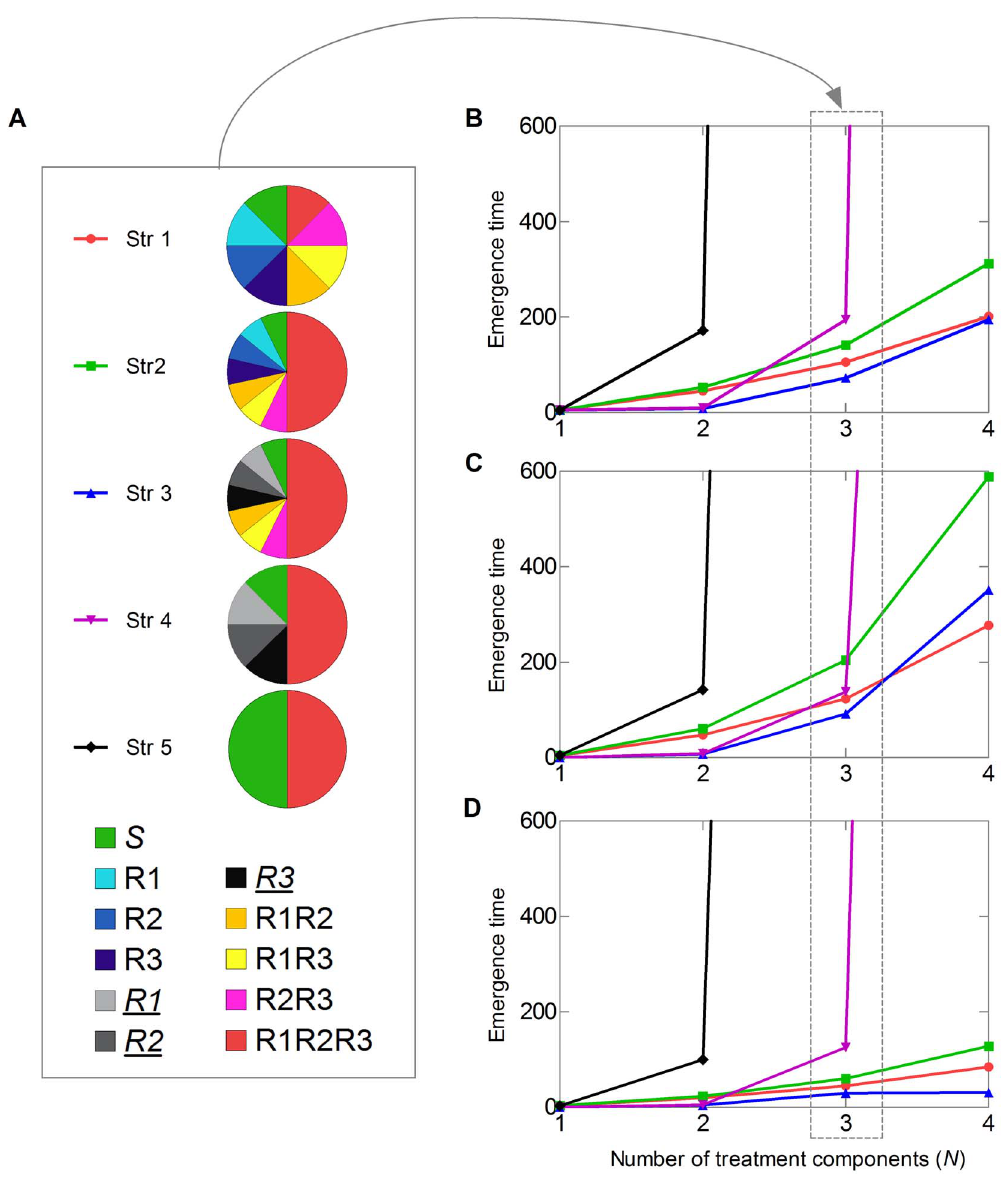
Figure 2. Emergence time as a function of the number of treatment components ( N ) for five different management strategies, Str1, ... , Str5. Pie charts (A) depict the composition of a diversified host population by the deployment of a three-component treatment ( N ~ 3 ): each color corresponds to a host type listed below, and the proportion of each host type corresponds to a pie sector. Host type S includes untreated hosts, types R1, R2, R3 and R1 , R2 , R3 - hosts receiving different monocomponent treatments, host types R1R2, R1R3, R2R3 receiving different intermediate treatments, and type R1R2R3 consists of hosts receiving a three-component treatment. Host types with italic and underline names receive defeated treatments that have already been overcome. For the detailed description of the management strategies, see the text in Materials and Methods section. We used the same deployment principle for the N -component treatment, N [ f 1, ... ,4 g . In (B), the pathogen has low growth and migration rates, r ~ 0 : 3 and D ~ 0 : 1 . Emergence time takes high values for Str ~ 4 and N ~ 4 , S 4,4 ~ 13764 : 3 , and for Str ~ 5 and N ~ 3 , S 5,3 ~ 12372 : 7 o . In (C), the pathogen has a low growth rate and a medium migration rate, r ~ 0 : 3 and D ~ 0 : 2 . S 4,4 ~ 4721 : 4 and S 5,3 ~ 9440 : 18 are the highest values of the emergence time. In (D), the pathogen has a medium growth rate and a low migration rate, r ~ 0 : 8 and D ~ 0 : 1 . S 4,4 ~ 9863 : 58 and S 5,3 ~ 8451 : 13 are the highest values of the emergence time. In (A-C), the other parameters are n ~ 10 { 3 , K ~ 10000 and C ~ 0 : 1 . In Str1, Str2 and Str5, the initial population size of the resident pathogen type is X 11 (0) ~ (1 { j ) K and for all other types ( i , j ) = (1,1) , X ij (0) ~ 0 . In Str3 and Str4, X 11 (0) ~ (1 { j ) K , X kk (0) ~ j i K where k corresponds to a host type treated with a monocomponent treatment, and for all other types ( i , j ) = (1,1) and ( i , j ) = ( k , k ) , X ij (0) ~ 0 . surviving grows if it is transmitted to a suitable treated host, where population size of pathogen type k on host type j increases by one. A given mutation is able to defeat only one component of the there is no competition. We use the term ‘migration’ to refer to the treatment. Since there is a mutation cost, and a high probability of transfer of an individual pathogen from one host to another; this can being outcompeted by the resident type, the mutant’s chance of correspond to droplet-borne, sexually transmitted, or vector-borne